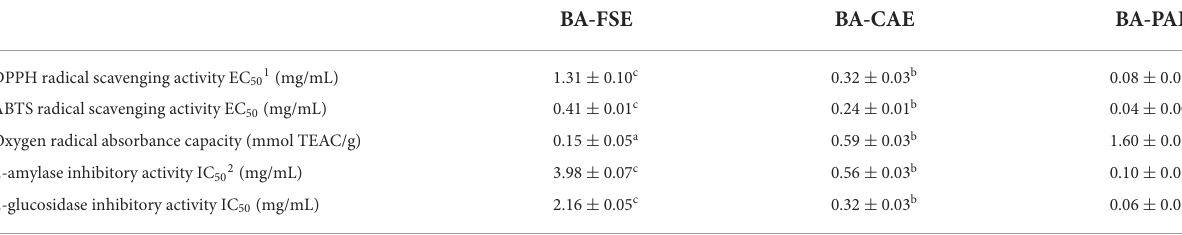
TABLE 3 Comparison of antioxidant and anti-hyperglycemic effects among the fruit slurry extract, crude anthocyanin extract, and purified anthocyanin extract.